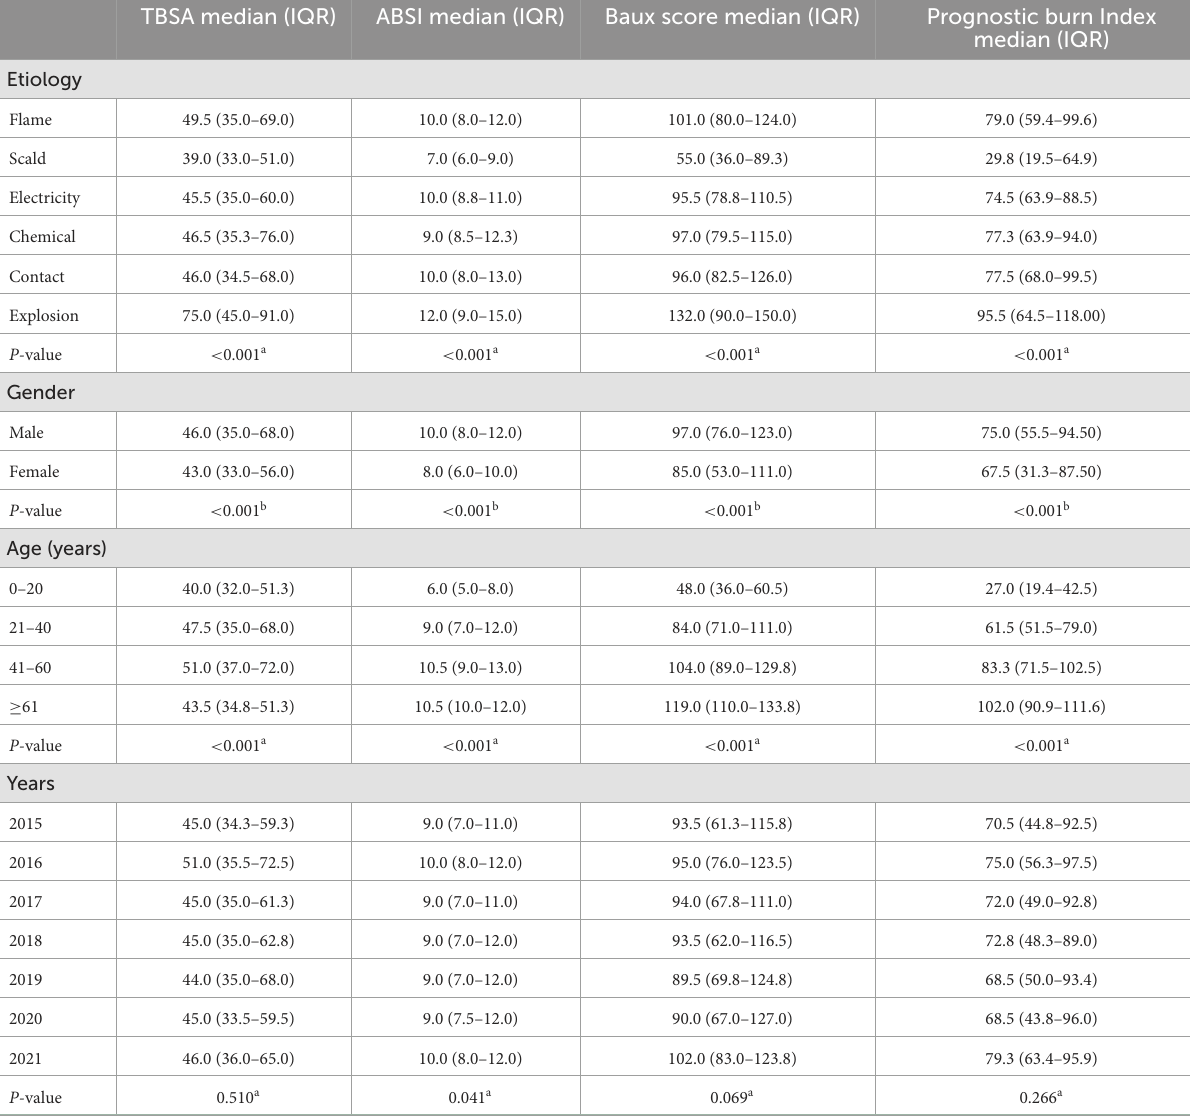
TABLE 2 Burn severity of the study population.